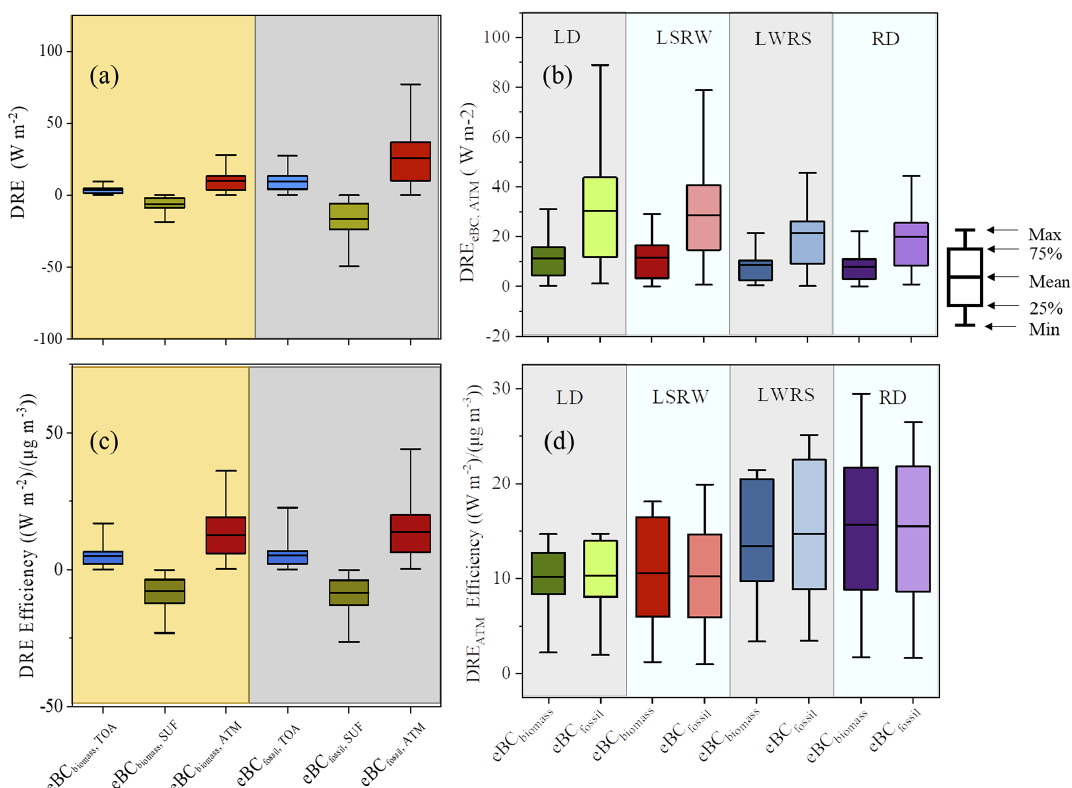
Figure 5. Direct radiative effect (DRE) of the e BC from fossil fuel combustion ( e BC fossil ) shaded in grey and the e BC from biomass burning ( e BC biomass ) shaded in yellow (a) at the top of the atmosphere (TOA), the surface (SUF), and the atmospheric column (ATM) and (b) DRE e BC , ATM of two types of e BC under LD shaded in light grey, LSRW shaded in light blue, LWRS shaded in light grey, and RD shaded in light blue. (c) DRE efficiencies of e BC biomass (shaded in yellow) and e BC fossil (shaded by grey) in TOA, SUF, and ATM. (d) DRE efficiencies of e BC biomass and e BC fossil at the ATM under LD (shaded in light grey), LSRW (shaded in light blue), LWRS (shaded in light grey), and RD (shaded in light